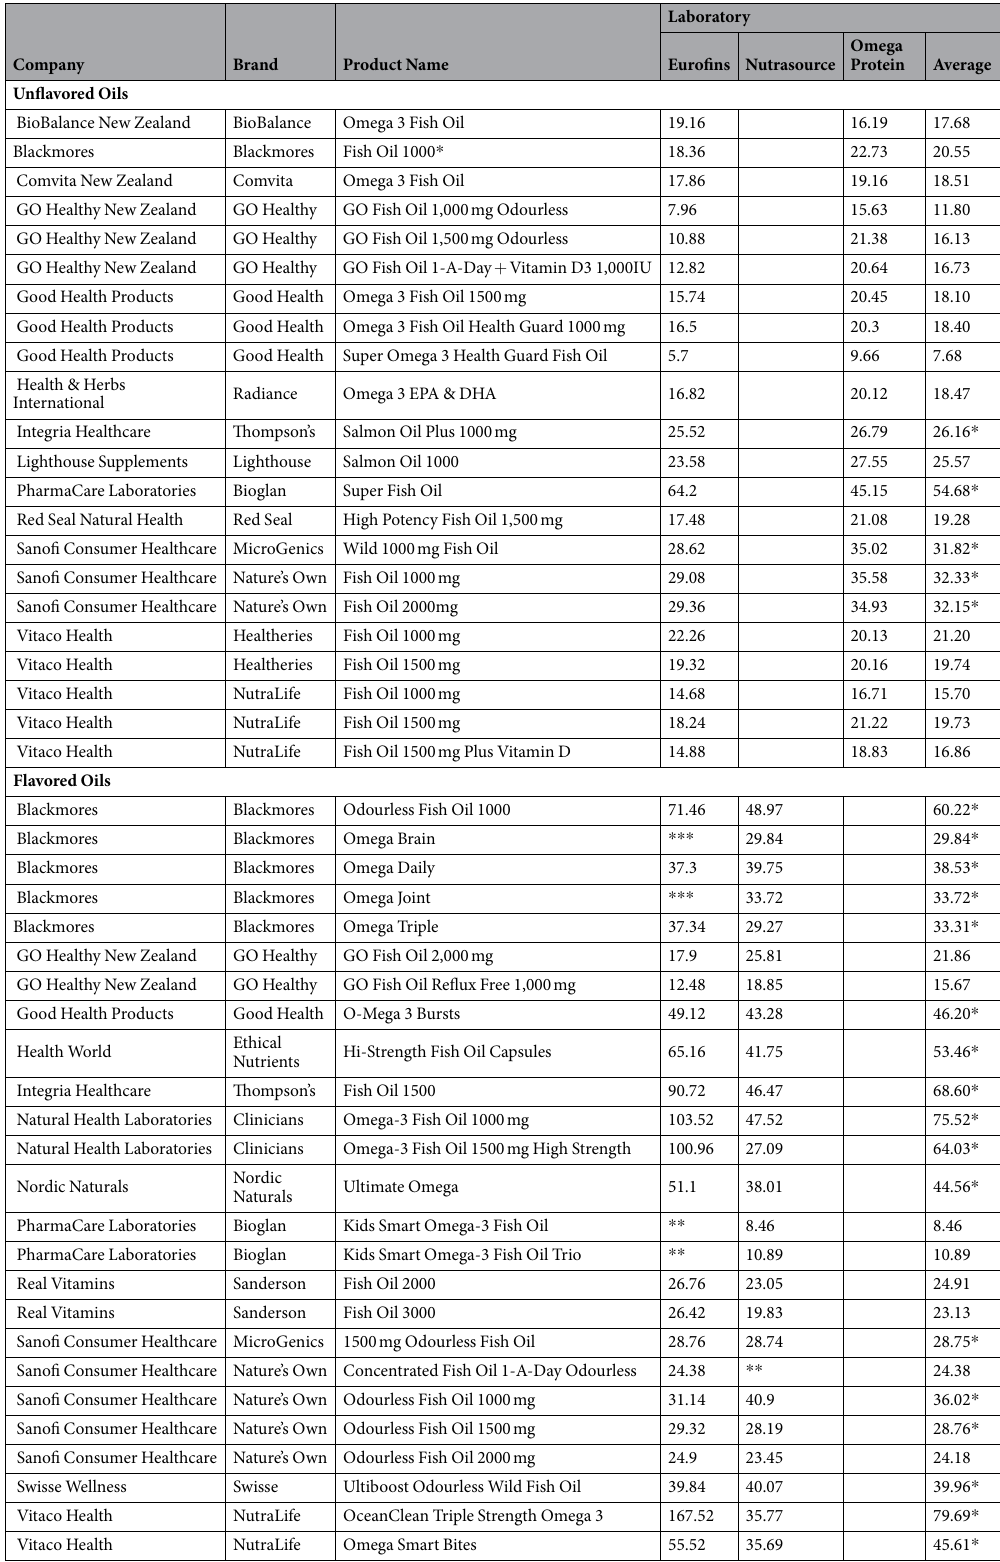
Table 3. TOTOX test results. * Indicates products where the average result from all laboratories exceeded the GOED Voluntary Monograph limit for TOTOX of 26. In the flavored oils these are noted for purposes of illustration only, as the TOTOX limit is not applicable to flavored oils due to the known interference of flavorings with the p-AV portion of the TOTOX calculation. ** Indicates products for which insufficient sample material was available for